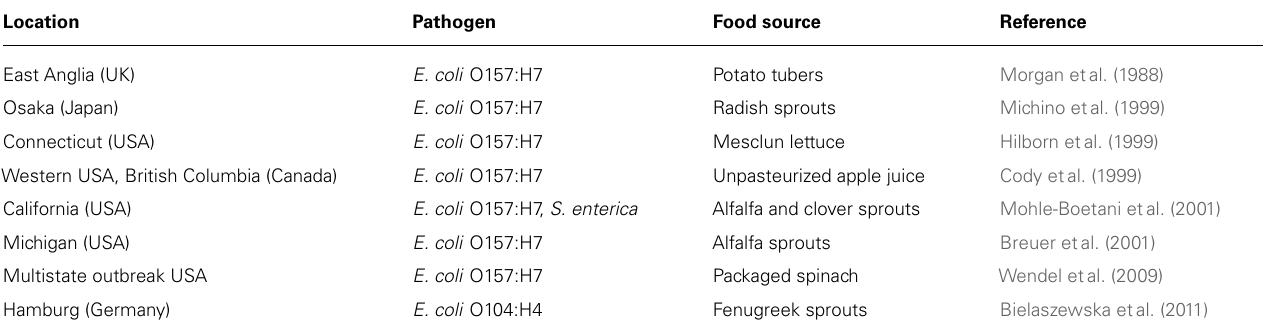
Table 1 | Examples of large disease outbreaks resulting from contamination of vegetables and sprouts with human pathogenic